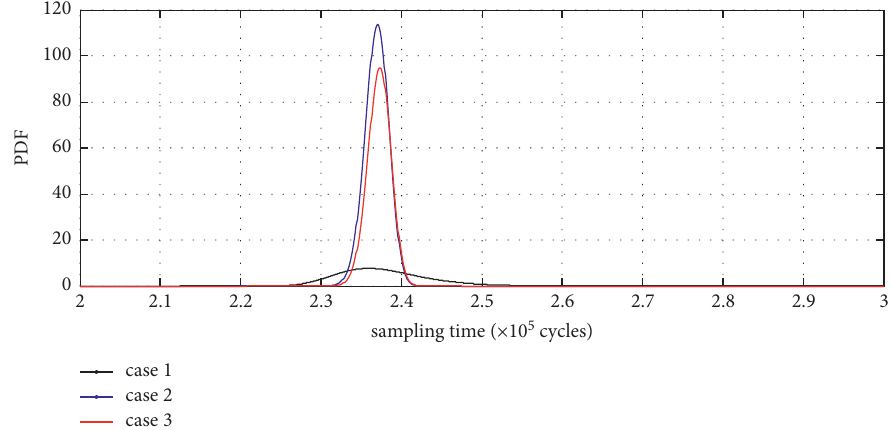
Figure 4: Comparison of the PDF of the lifetime for Cases 1–3 of the fatigue crack propagation data.